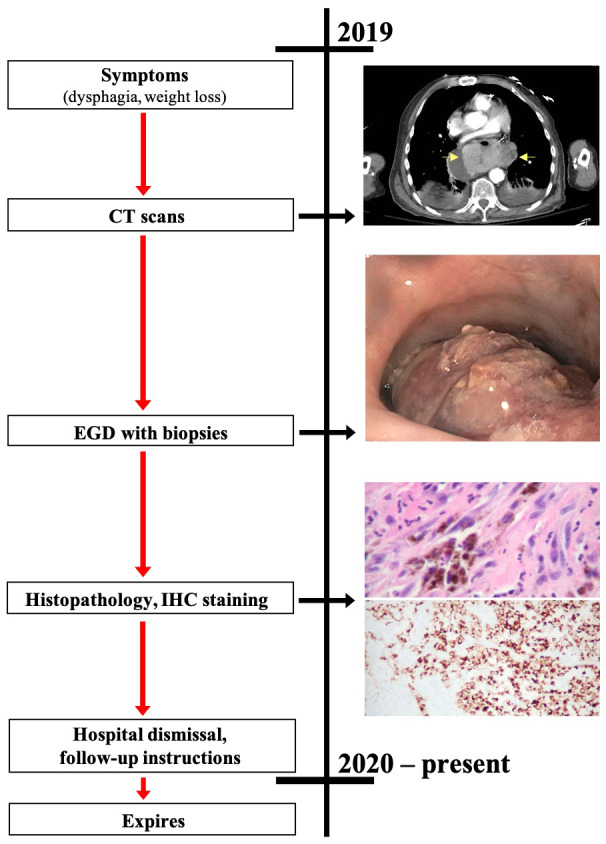
Case report timelinePresented according to CARE guidelines.